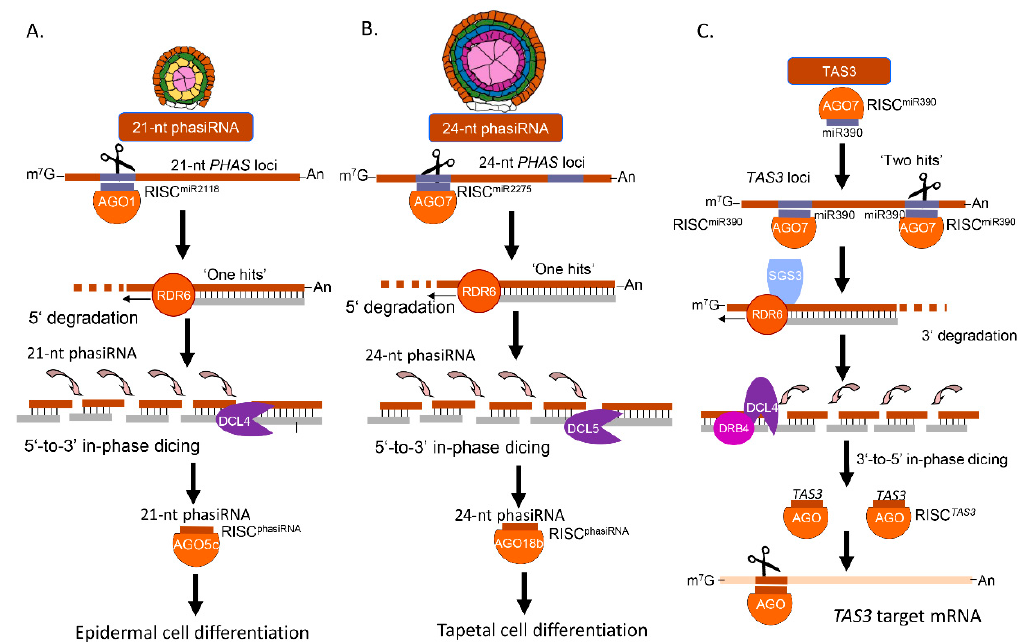
Figure 2. Phased small interfering RNA (phasiRNA) and trans-acting simple interfering RNA (tasiRNA) biogenesis pathways in maize. ( A ) The 21 nt phasiRNA biogenesis pathway. ( B ) The 24 nt phasiRNA biogenesis pathway. The regulatory mechanism of 24 nt has not been fully uncovered. ( C ) TAS3 -tasiRNA biogenesis pathway.